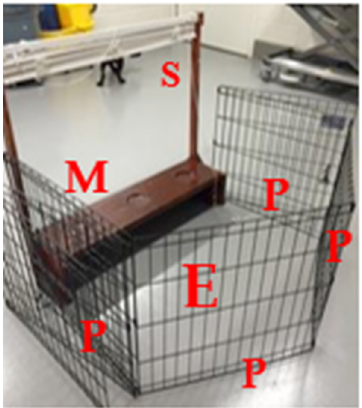
Figure 1. Modified testing apparatus. Dogs were trained to position face forward on the mat ( M ). The experimenter ( E ) remained behind the apparatus within an exercise pen with opaque panels ( P ) (not shown) and a functional shade ( S ). Supplies for each trial were kept underneath the tray of the apparatus.